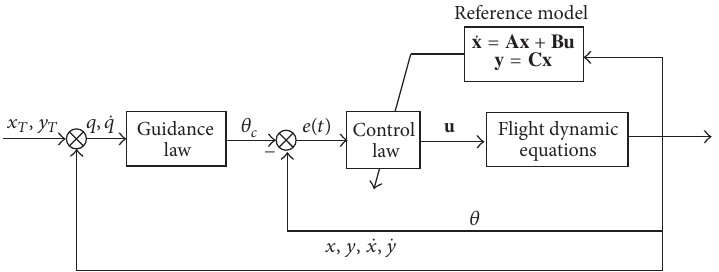
Figure 2: Control and guidance structure of impulsive-correction projectile.